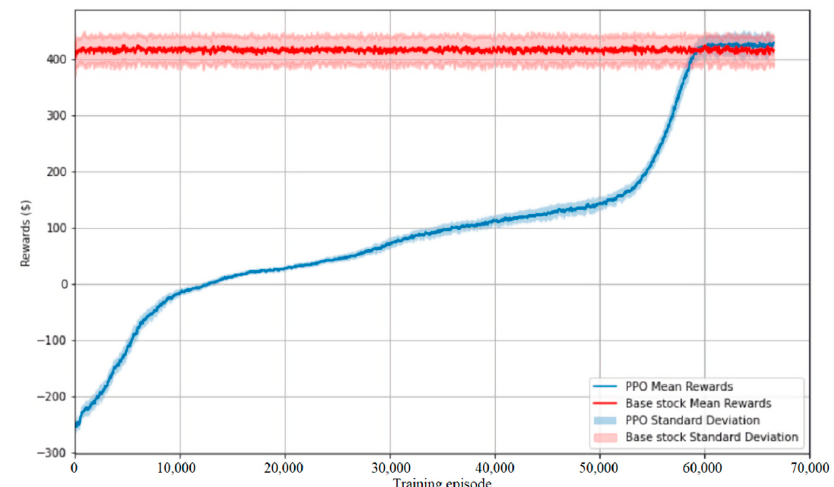
Figure 3. Learning curve. The PPO agent performance is measured by reward increases during training episodes.